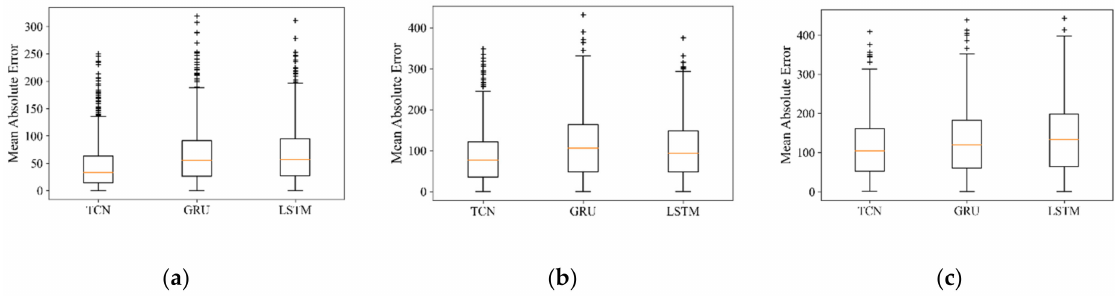
Figure 13. Boxplot with different forecasting steps. ( a ) 6 steps; ( b ) 12 steps; ( c ) 24 steps. Table 4. Execution time of contrast models for the GEFCom datasets.